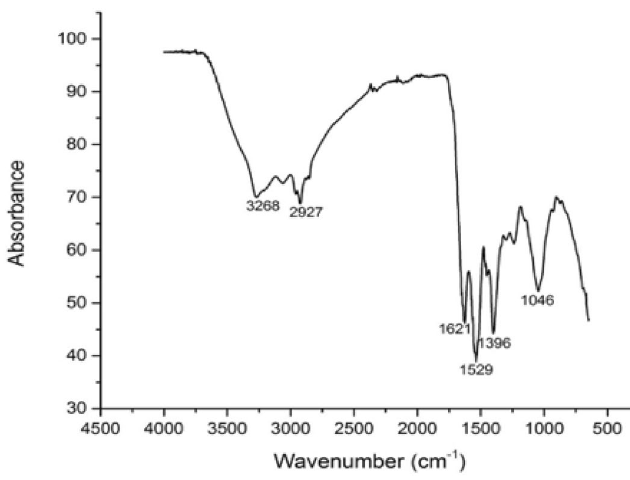
Figure 4. FTIR spectra of biosynthesized silver nanoparticles by Bacillus cereus